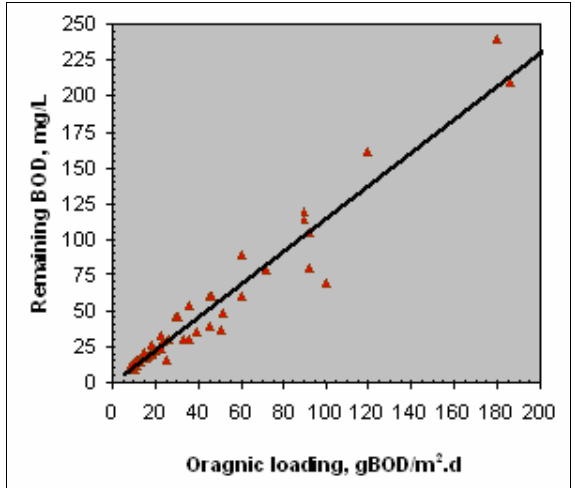
Figure 14: Effect of organic loading in g BOD/m 2 .d on the remaining BOD.